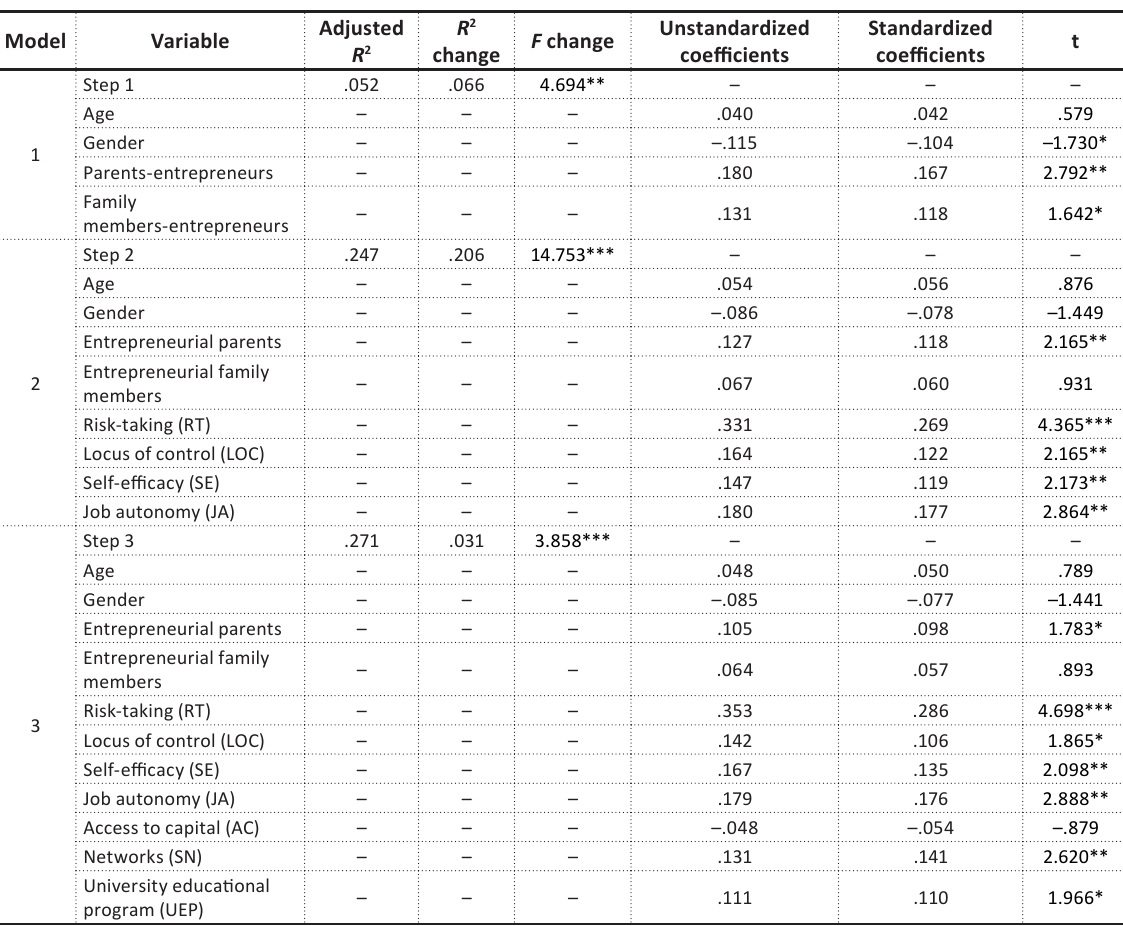
Table 3. Hierarchical multiple regression